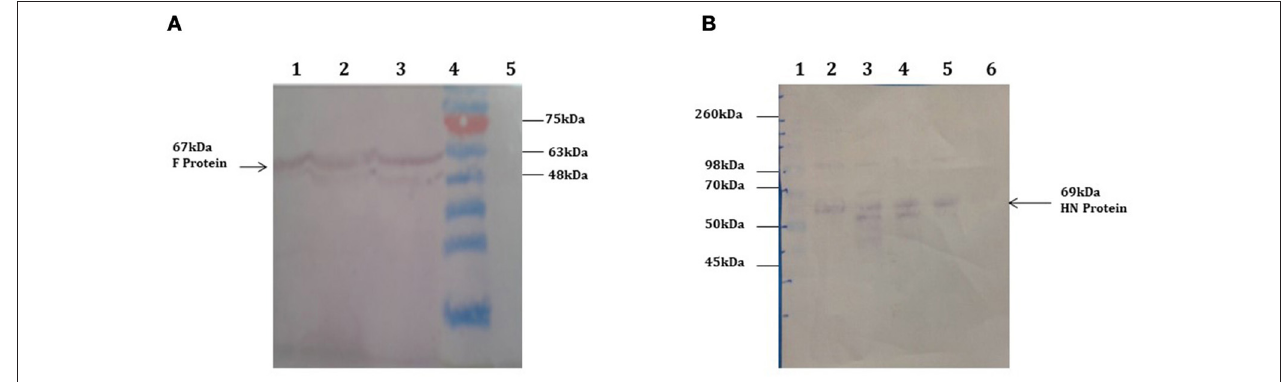
FIGURE 7 | Western blot analysis demonstrating the expression of F and HN protein in transgenic plants. Total soluble protein extracted from transgenic maize leaves and seeds transformed by agrobacterium mediated transformation. (A) 67 kDa protein band was obtained by western blot from transgenic maize leaves confirms the expression of F protein in leaves. Lanes 1–3, TSP from transgenic plants showing 67 kda F protein; Lane 4, Pre-stained protein marker (Fermentas); Lane 5, Negative control (wild type plant). (B) 69 kDa protein band was obtained by western blot from transgenic maize seeds confirms the expression of HN protein in seeds. Lane 1,